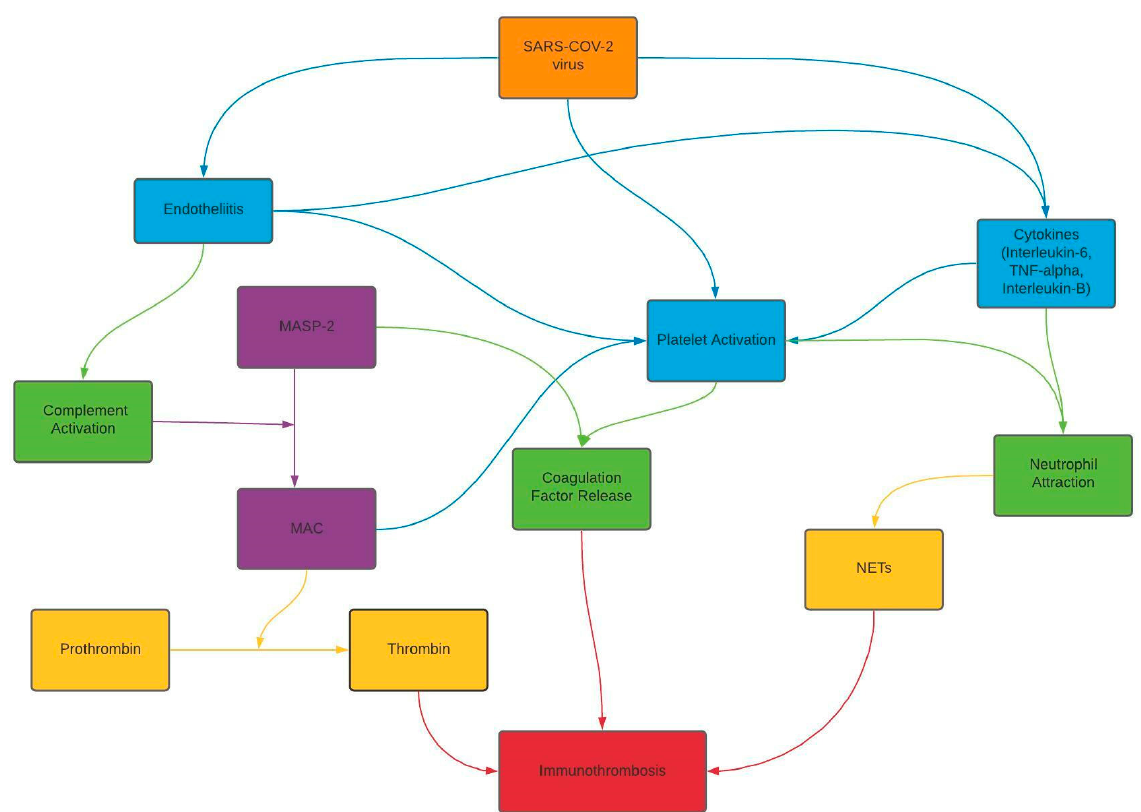
Scheme 1. Flow chart depicting the multiple factors contributing to the hypothesized mechanisms of thrombus formation secondary to SARS-CoV-2 virus infection.